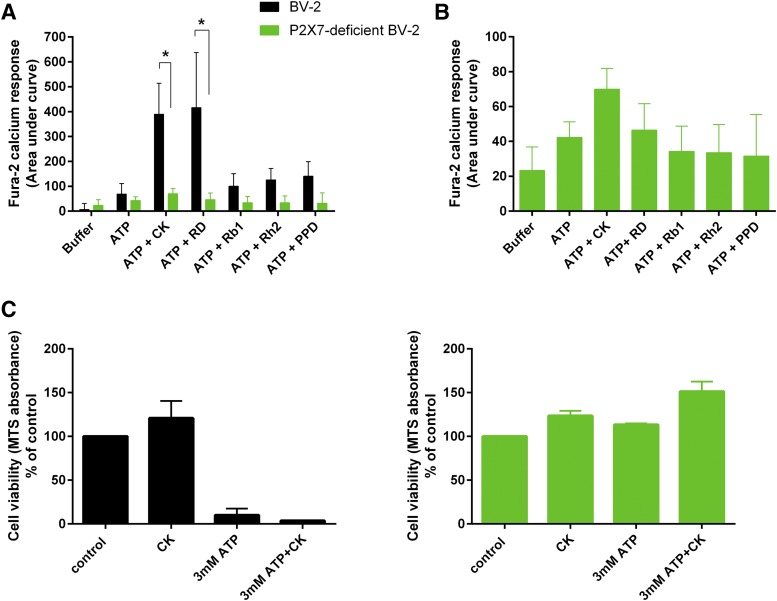
Ginsenosides show little potentiation of ATP-induced responses in BV-2 microglia in the absence of P2X7. (A and B) Intracellular calcium measurements were performed using a no-wash Fura-2-QBT assay on parental BV-2 cells and P2X7-deficient BV-2 microglia cells. ATP (200 μM) was injected in the absence or presence of various ginsenosides (all 10 μM). Calcium responses were calculated as area under curve using Softmax Pro software. Significant potentiation was only evident in cells expressing P2X7. Data are from three independent experiments, error bars represent S.D., and *indicates P < 0.05 using two-way ANOVA with Bonferroni’s multiple comparison post hoc test. (C) Cell viability was assessed using MTS reagent. BV-2 cells were plated for 24 hours prior to stimulation with ATP in the absence or presence of ginsenoside CK (10 μM). Cells were treated for 24 hours, and MTS was added for the final 1 hour. Data are represented as mean percentage of control values in which control was vehicle-treated cells. Data are from three independent experiments, error bars represent S.D., and *indicates P < 0.05 using one-way ANOVA with Dunnett’s multiple comparison post hoc test.